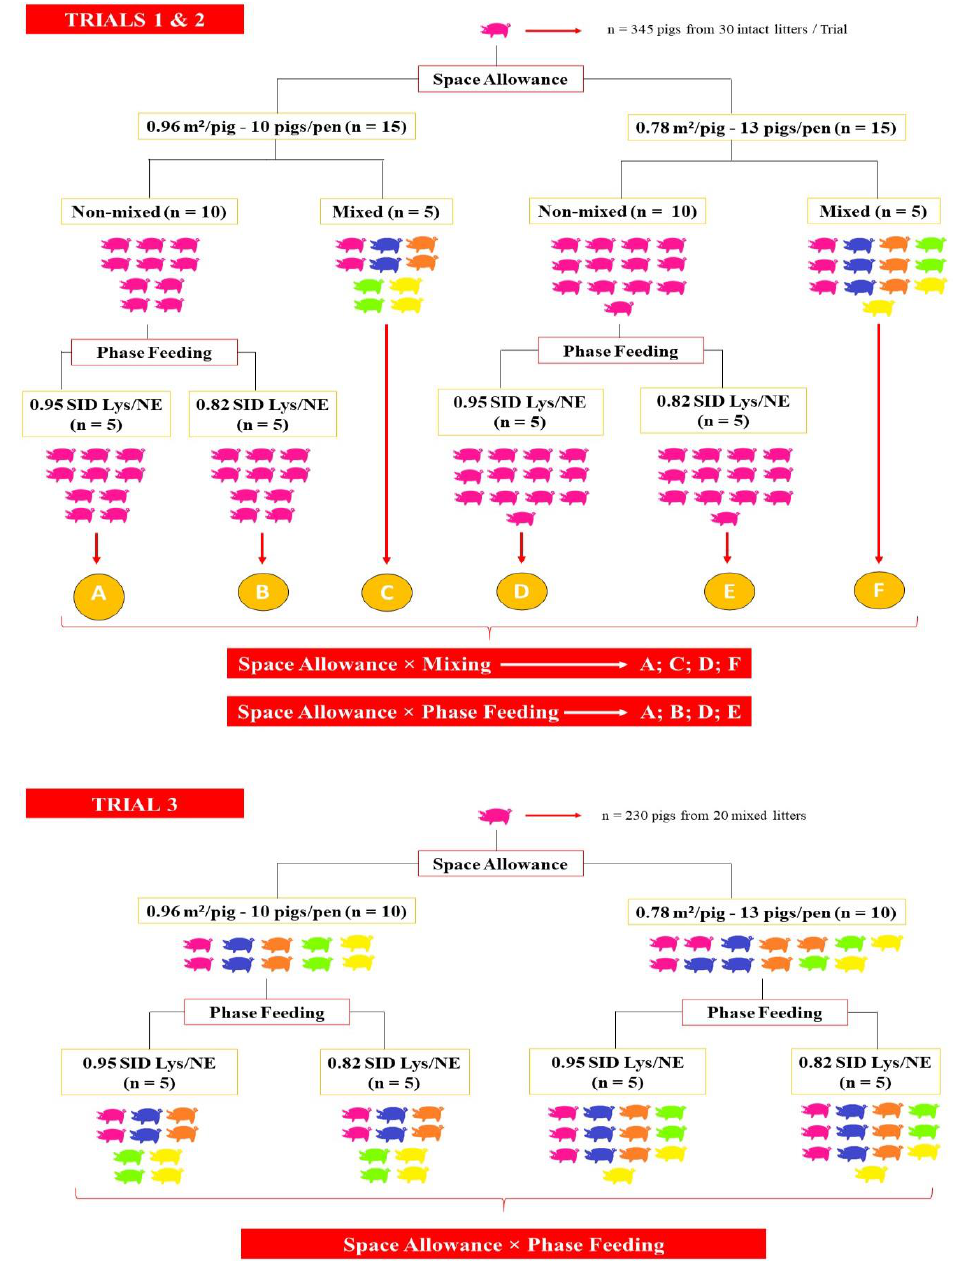
Figure 1. Schematic illustration of the experimental design in trial 1, 2 and 3. In trials 1 and 2, experimental design was a two 2 × 2 factorial arrangement with space allowance and mixing as treatments and space allowance and phase feeding as treatments. In trial 3, experimental design was a 2 × 2 factorial arrangement with space allowance and phase feeding as treatments, and mixing was applied to all the pens. Space allowances were above the minimum space per pig set by European legislation based on live weight